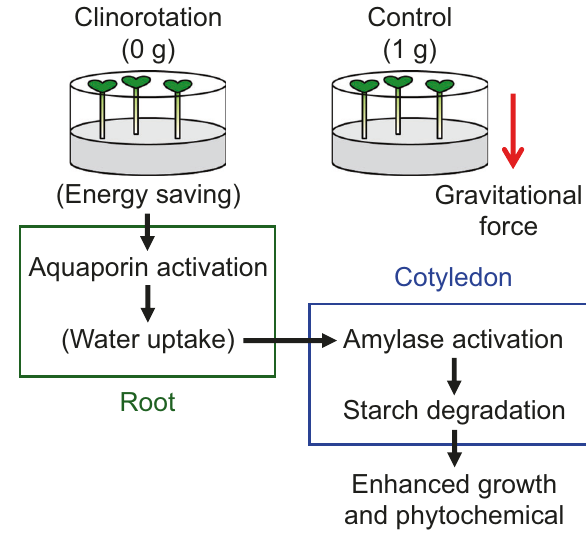
Fig. 3 The potential mechanism for a positive growth in mung bean seedling grown under clinorotation obtained in this and our previous study 19 . The green area was observed in roots, whereas the blue area was observed in cotyledons. Parentheses are discussions and not obtained data.